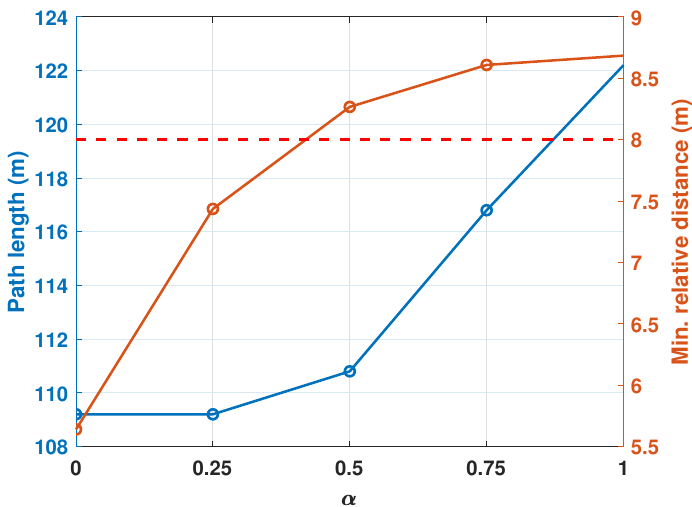
Figure 7. Path length and minimum relative distance in accordance with α .